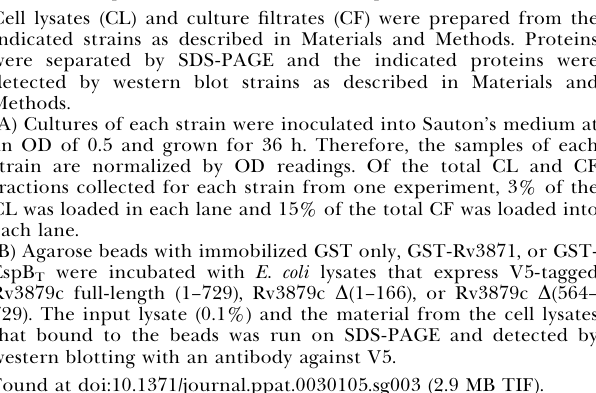
Figure S1. Colony Morphology of espB M ::tn Dilutions of each strain were grown on 7H10 agar, without antibiotics, and imaged after 12 d. Found at doi:10.1371/journal.ppat.0030105.sg001 (5.9 MB TIF). Figure S2. Mh3871 Is Required for the Secretion of EspB M Cell lysates (CL) and culture filtrates (CF) were prepared from wild- type M. marinum strain 1218 and isogenic mutants as described in Materials and Methods. CL and CF proteins were separated by SDS- PAGE and the indicated proteins detected by western blot. Cultures of each strain were inoculated into Sauton’s medium at an optical density (OD) of 0.5 and grown for 36 h. Therefore, the samples of each strain are normalized by OD readings. Of the total CL and CF fractions collected for each strain from one experiment, 3% of the CL was loaded in each lane and 15% of the total CF was loaded into each lane. Figure S3. Mh3879c Is Not Secreted and the Carboxyterminus of Rv3879 Is Required for Interaction with EspB Cell lysates (CL) and culture filtrates (CF) were prepared from the indicated strains as described in Materials and Methods. Proteins were separated by SDS-PAGE and the indicated proteins were detected by western blot. (A) Cultures of each strain were inoculated into Sauton’s medium at an OD of 0.5 and grown for 36 h. Therefore, the samples of each strain are normalized by OD readings. Of the total CL and CF fractions collected for each strain from one experiment, 3% of the CL was loaded in each lane and 15% of the total CF was loaded into each lane. (B) Agarose beads with immobilized GST only, GST-Rv3871, or GST- EspB T were incubated with E. coli lysates that express V5-tagged Rv3879c full-length (1–729), Rv3879c D (1–166), or Rv3879c D (564– 729). The input lysate (0.1%) and the material from the cell